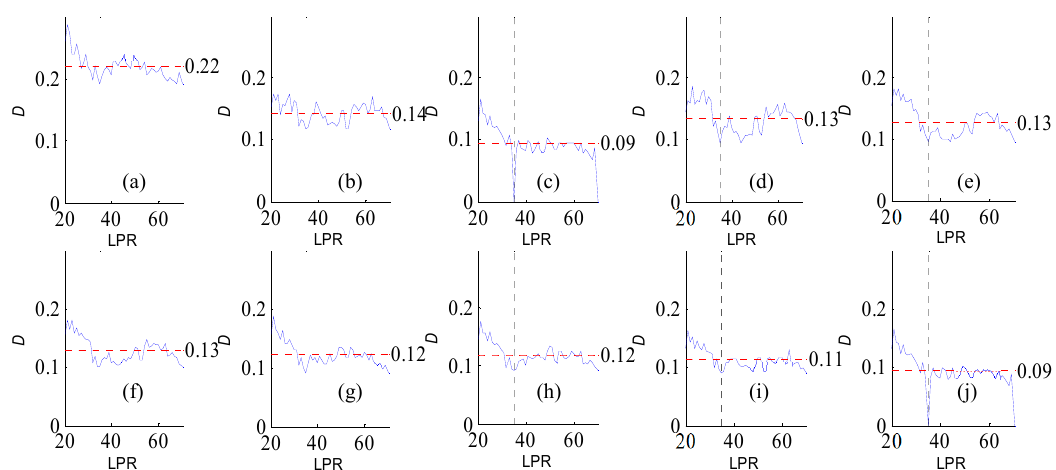
Figure A20. Variation of flow regime alteration degree (D) measured by the RVA with change in the length of post-impact flow time series (LPR) under a periodicity of 34 years. ( a ), ( b ), ( c ), ( d ), ( e ), ( f ), ( g ), ( h ), ( i ), and ( j ) correspond to pre-impact flow time series length = 24, 29, 34, 39, 44, 49, 53, 58, 63, and 68 years, respectively. The abscissa value for the vertical dotted line is 34. The ordinate value for the horizontal dotted line is the mean degree of flow regime alteration in each subfigure.